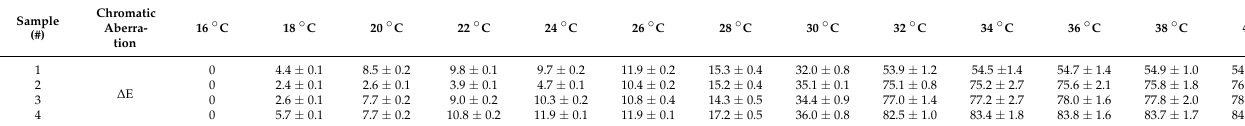
Table 4. The temperature rise (16 ◦ C to 40 ◦ C) on colorimetric aberration of film.